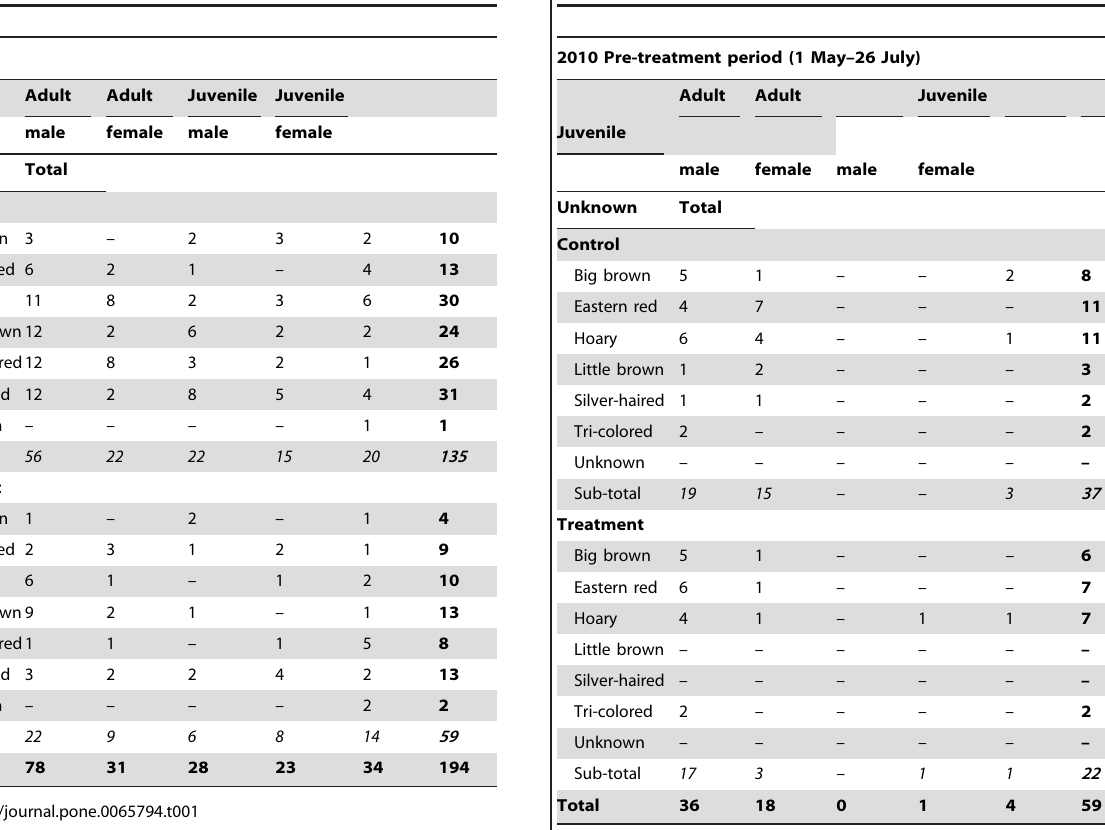
Table 1. Number of bats by species and age/sex class found Table 2. Number of bats by species and age/sex class